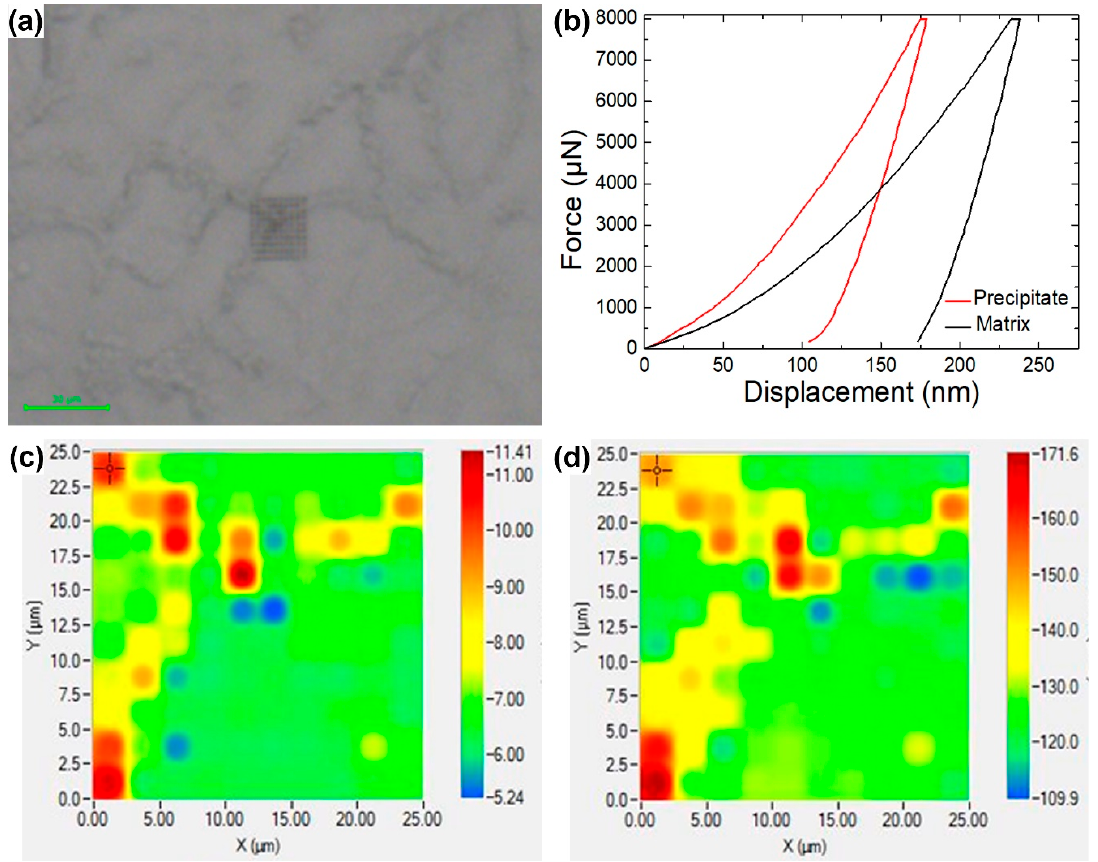
Figure 4. Nanoindentation mappings of RHEA-B sample: ( a ) mapping area (central dark grey square), ( b ) representative load–displacement curves in the matrix (grain) and at the precipitate (grain boundary), ( c ) reduced modulus mapping, ( d ) hardness mappings.